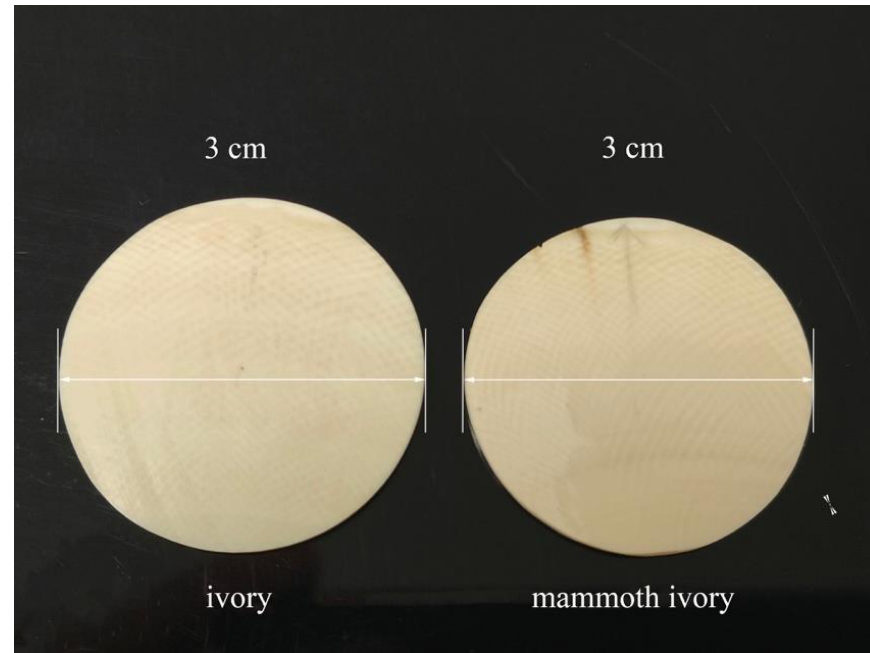
Figure 5. Specimens for the X-ray pole figures.